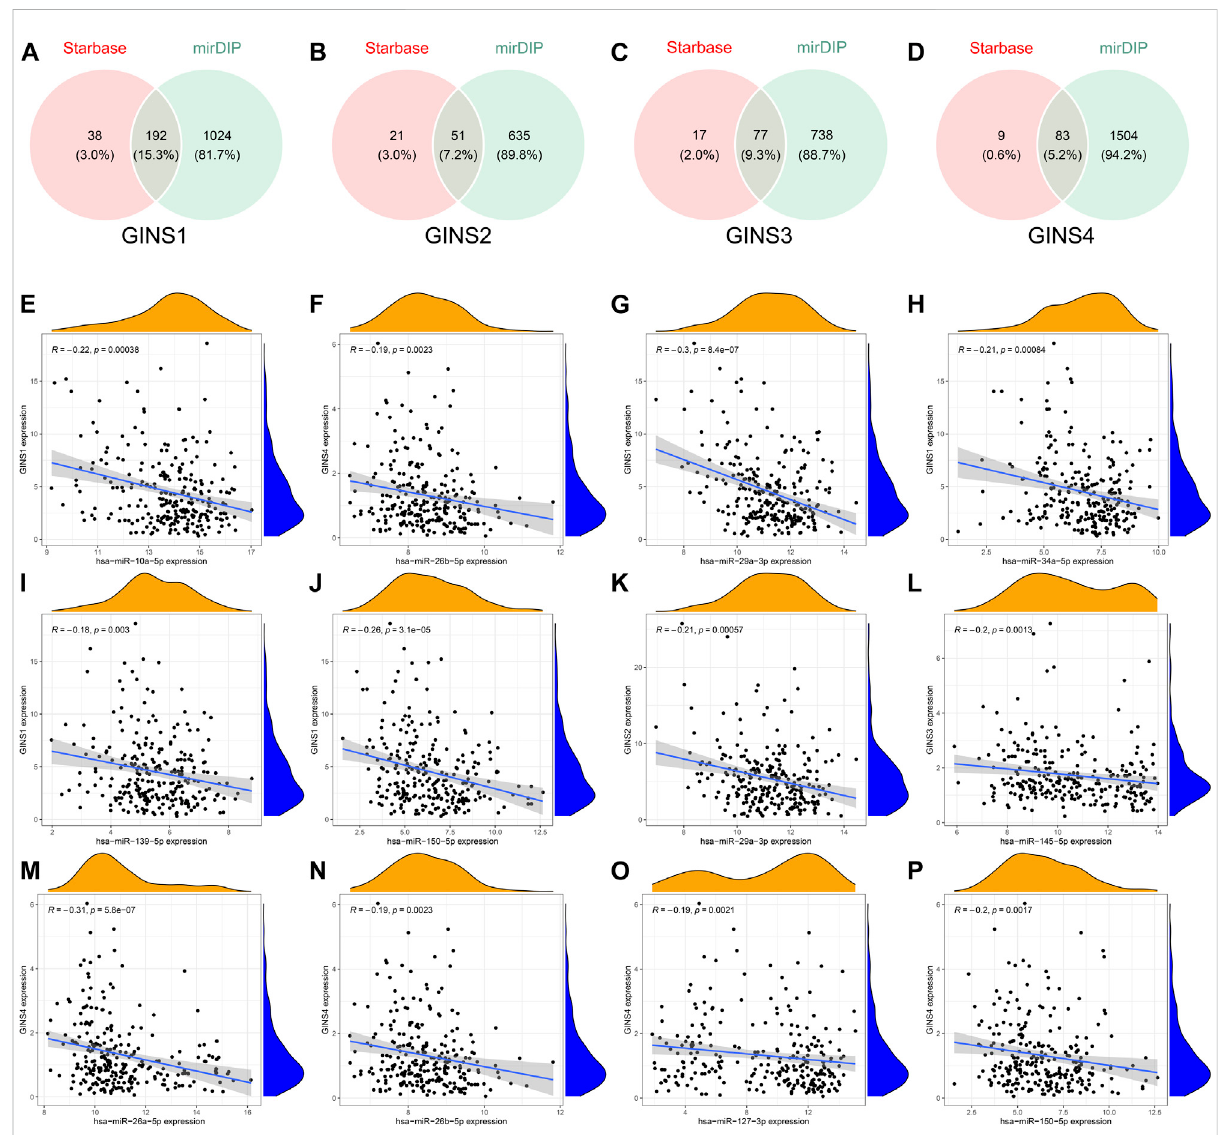
FIGURE 10 Comprehensive analysis of miRNAs targeting GINS1/2/3/4 in SARC. Venn graphs illustrating common miRNAs predicted to target GINS1/2/3/ 4 by Starbase and mirDIP (A – D) . The miRNAs negatively co-expressed with GINS1/2/3/4 (E – P) .